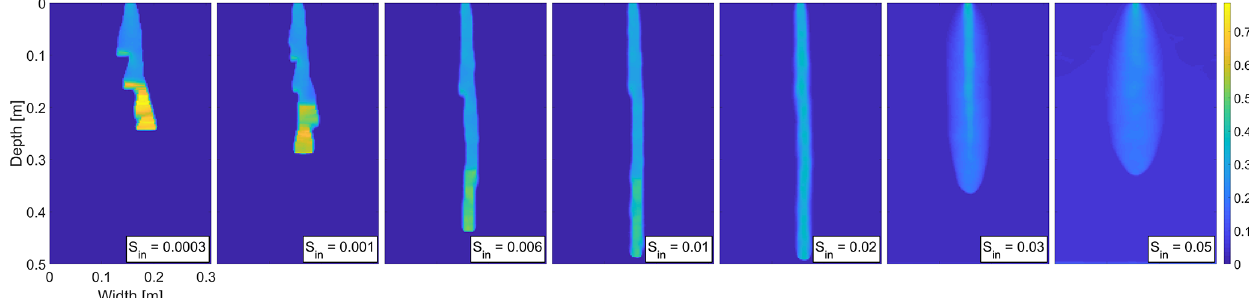
Figure A7. Snapshot of the saturation field at 25min for seven different values of the initial saturation for the distribution which satisfies κ max /κ min ≈ 2 . 35 (the distribution in Fig. A2f). Saturation values are color coded according to the color bar on the